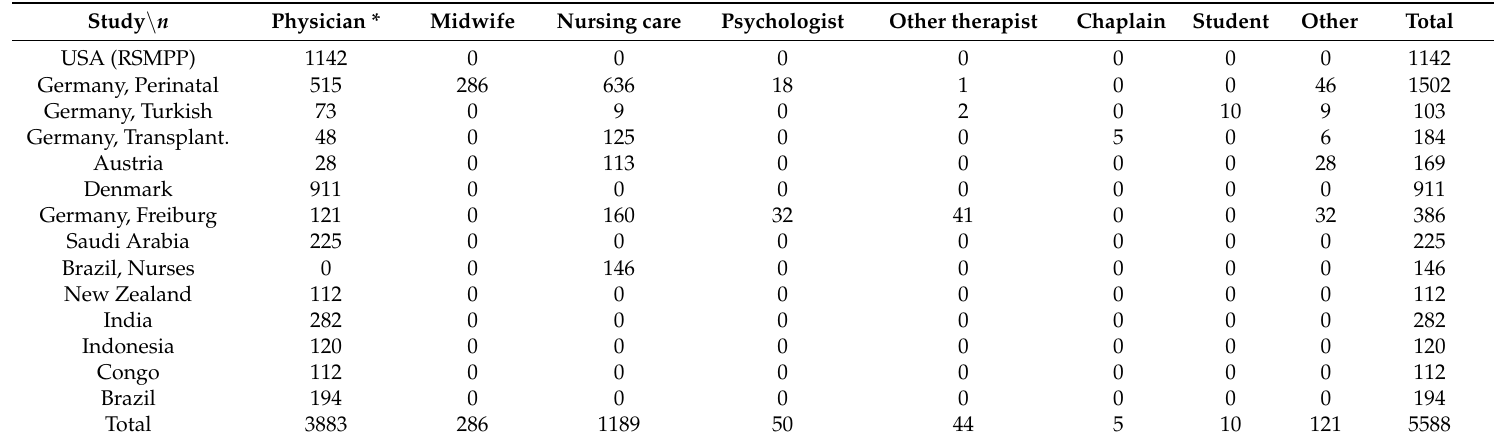
Table 4. Distribution of occupations in the studies.